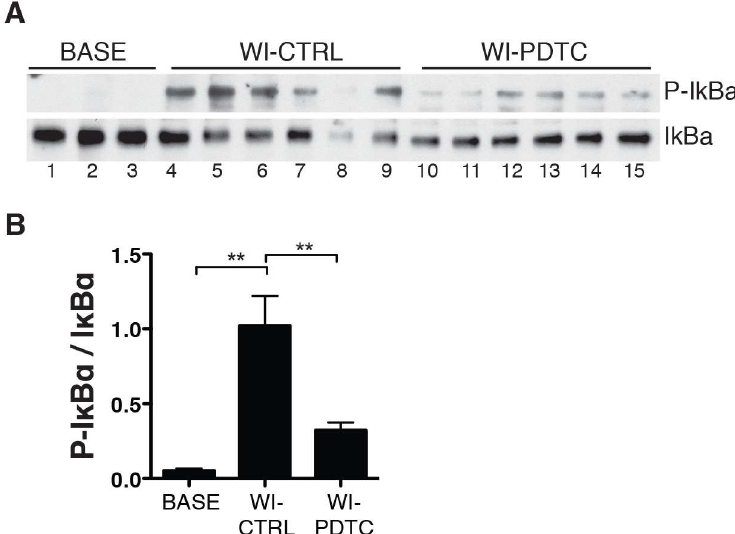
Fig 7. Phosphorylation and degradation of I κ B α in lung tissue. Western immunoblots of I κ B α and phospho-I κ B α in all lungs (A). The graph depicts the ratio of the densitometric analysisof phospho-I κ B α and I κ B α (B). Means ± s.e.m; ** p < 0.01(ANOVA followedby Tukey’s